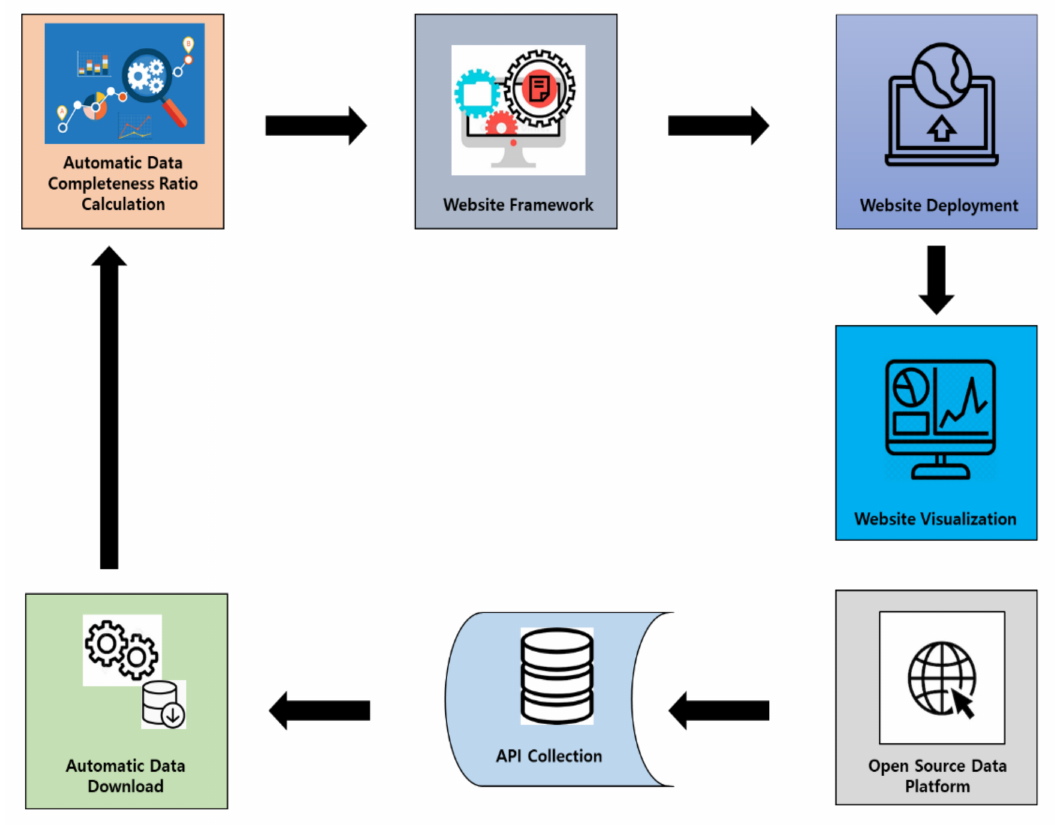
Figure 2. A framework to check the DCR of data stored in